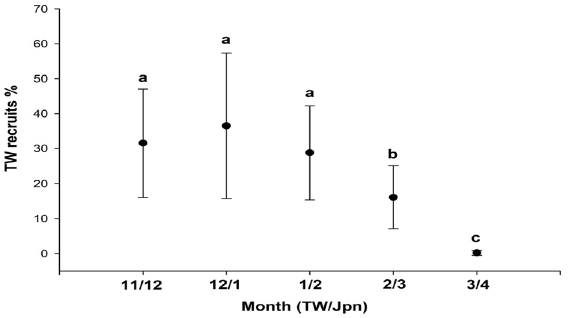
Figure 8. The relative abundance of Japanese glass eels between Taiwan (TW) and Japan (Jpn) from November/ December to